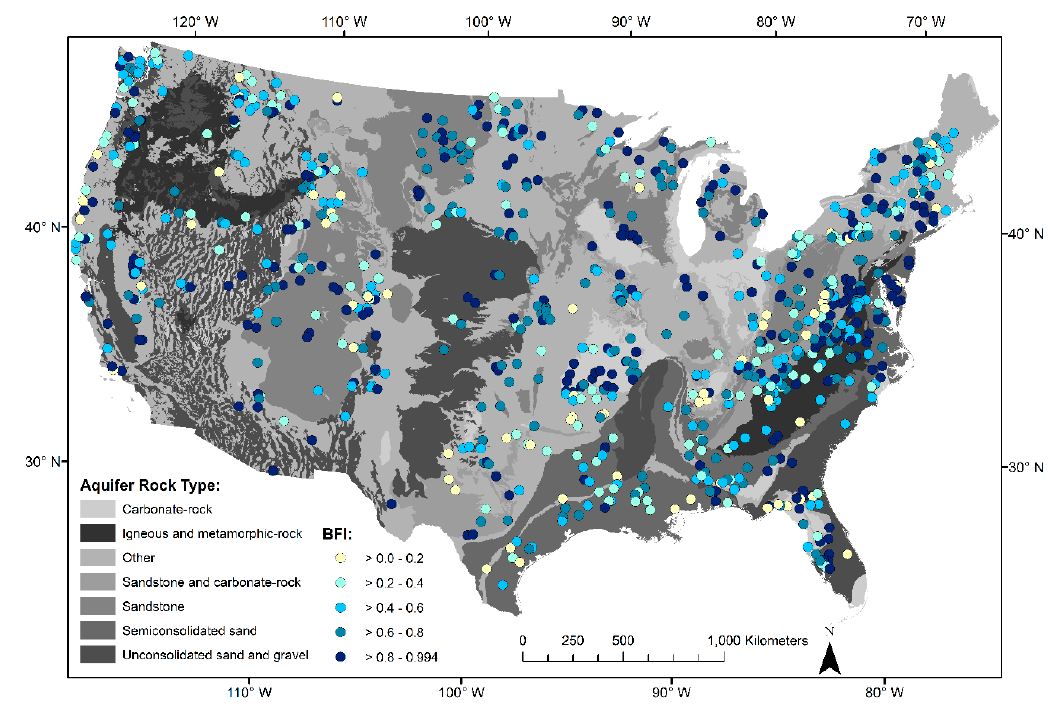
Figure 6. Spatial distribution of long-term average BFI (fraction) of sites with accepted OHS models (n = 825), presented among aquifer type within the CONUS. The average BFI values are variable throughout the CONUS, without distinct regional patterns.